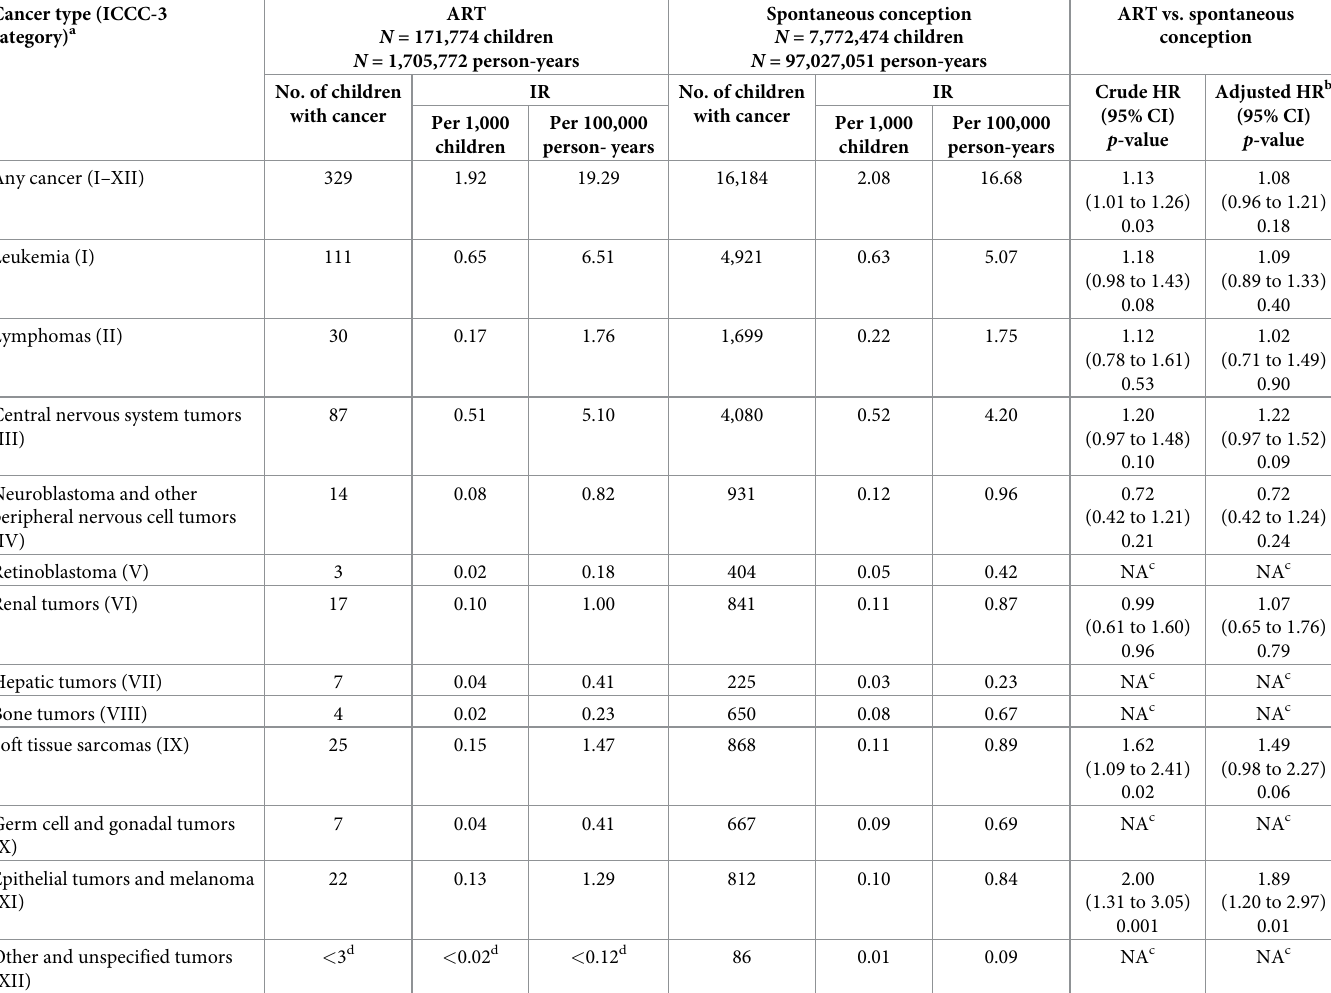
Table 3. IR and risk of any cancer and type of cancer according to ICCC-3 categories before 18 years of age by first diagnosis and mode of conception in children born in Denmark, Finland, Norway, or Sweden (Denmark 1994–2014, Finland 1990–2014, Norway 1984–2015, and Sweden 1985–2015). Cancer type (ICCC-3 category)